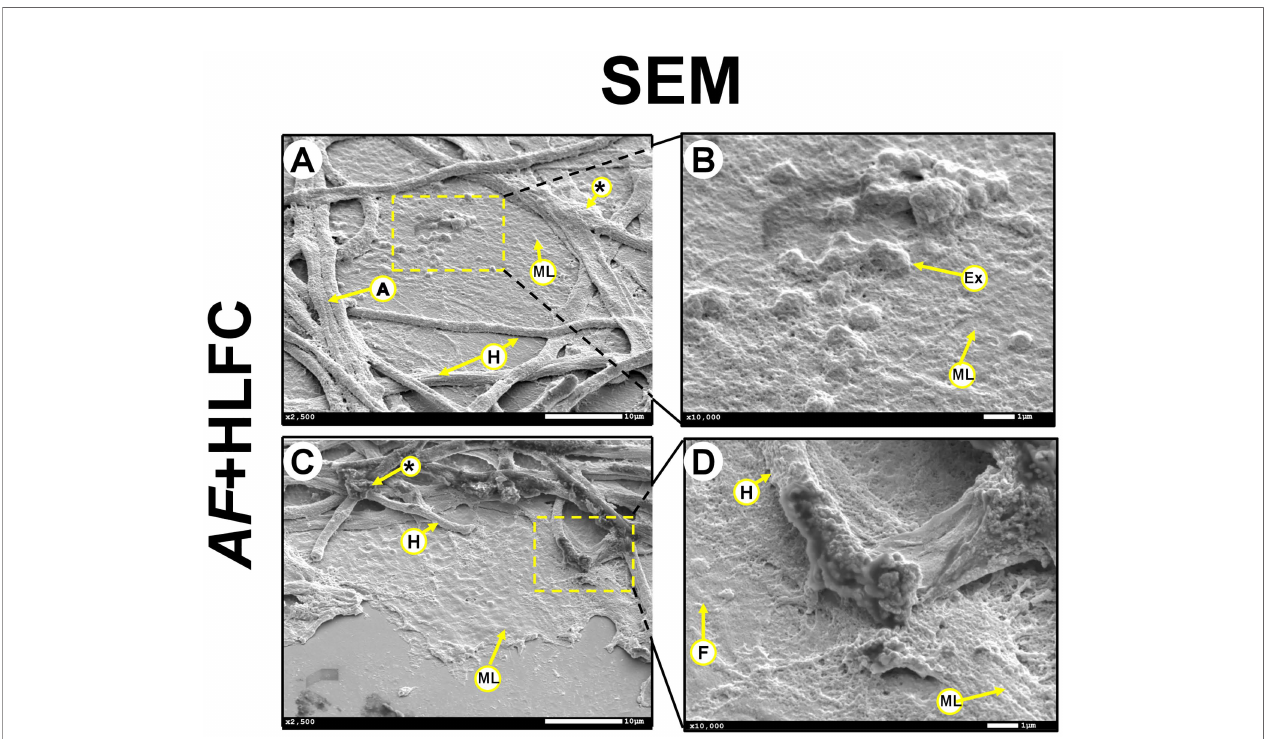
FIGURE 4 | Interaction between AF bio fi lm and HLFCs. SEM micrographs showed an antifungal effect caused by the HLFC at 24 h. The HLFC showed exosome- like structures that produce damage to the hyphae ( A : 2,500×; B : 10,000×). Hypha damaged in the apical zone. ( C : 2,500×; D : 10,000×). HLFCs, human limbo- corneal fi broblast cells; AF, Aspergillus fumigatus ; H, hypha; F, fi broblast; A, anastomosis; asterisk (*), extracellular matrix; Ex, exosome like; ML,